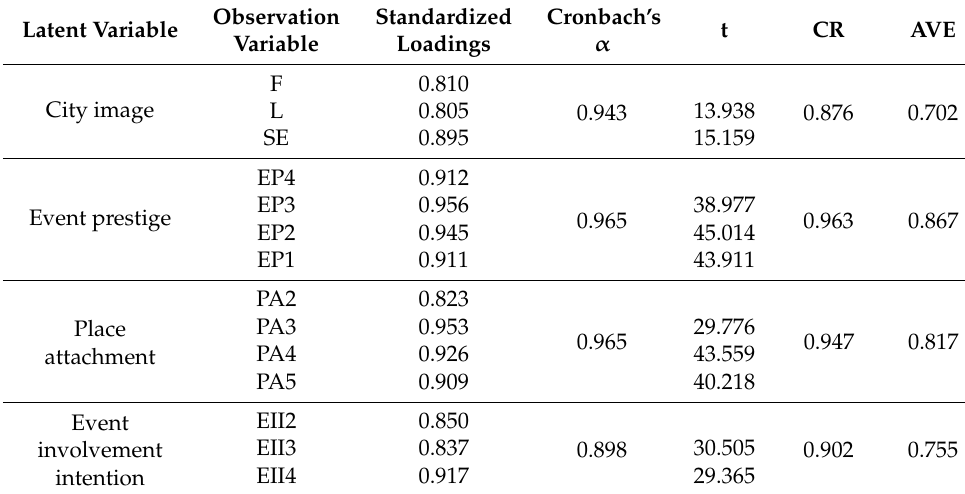
Table 2. Results of the confirmatory factor analysis.